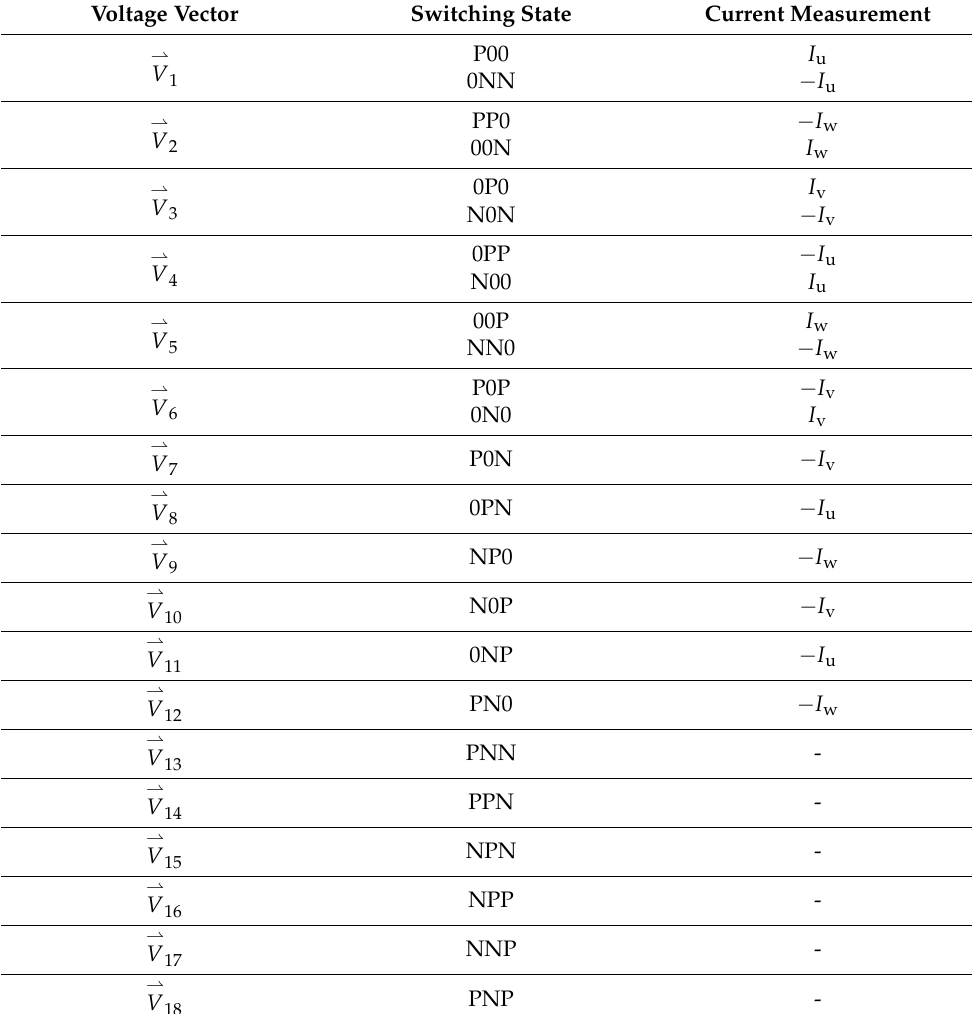
Table 5. Current